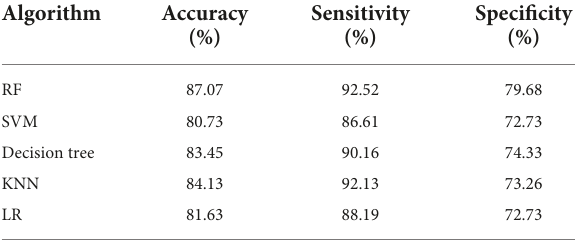
TABLE 3 Performance of the simple model.